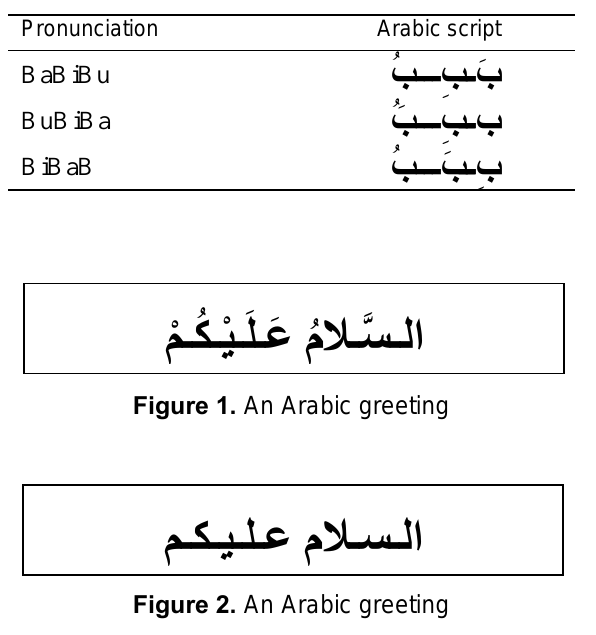
Figure 2. An Arabic greeting